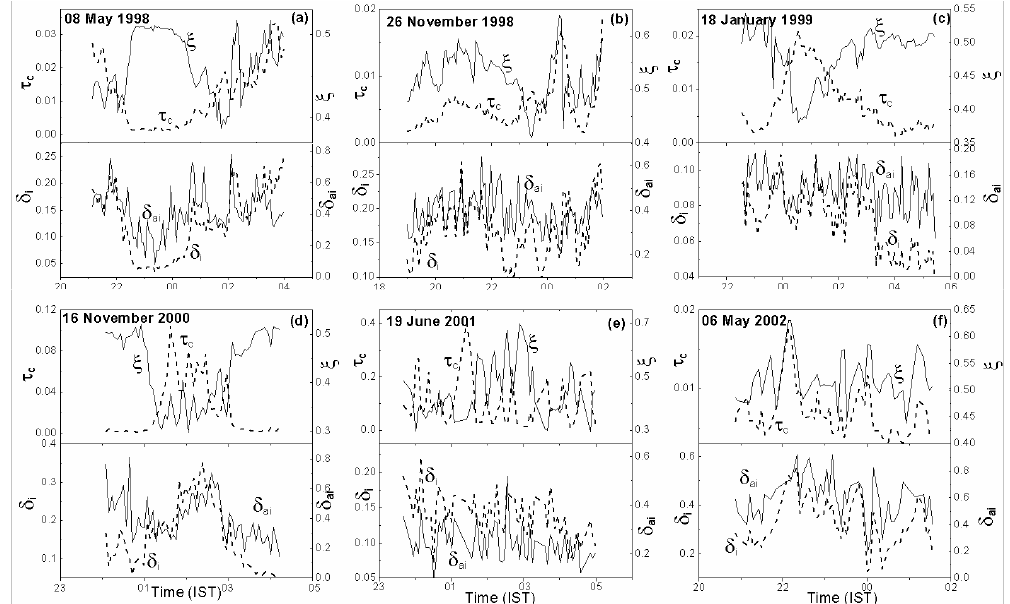
Fig. 5. Temporal variations of cloud asymmetry factor ( ξ) , cloud optical depth, volume depolarization ( δ i ) and particulate depolarization Figure 5 ( δai ) of the cloud on different nights showing distinct features.